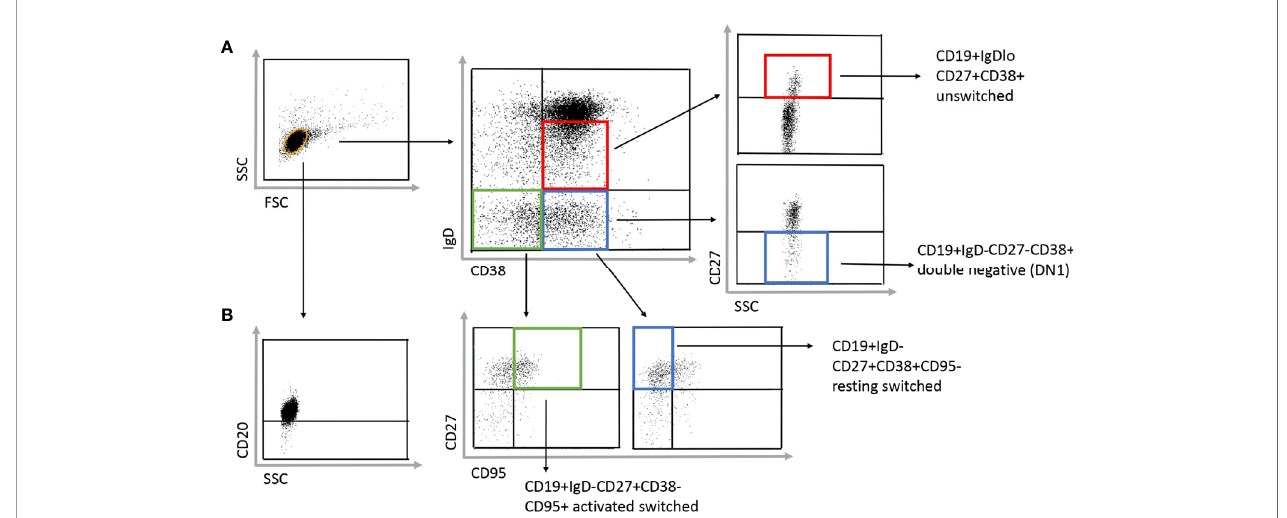
FIGURE 1 | Gating strategy to identify the investigated four subgroups of memory B cells in SSc patients. (A) The CD19+ puri fi ed B cells were stained with IgD, CD38, CD27 and CD95 de fi ning the following subsets: CD19+IgDloCD27+CD38+ unswitched, CD19+IgD − CD27 − CD38+ double negative (DN) 1, CD19+IgD − CD27+CD38+CD95 − resting switched and CD19+IgD − CD27+CD38 − CD95+ activated switched memory B cells. (B) To check the purity of the separated B cell, cells were stained with anti-CD20 antibody after